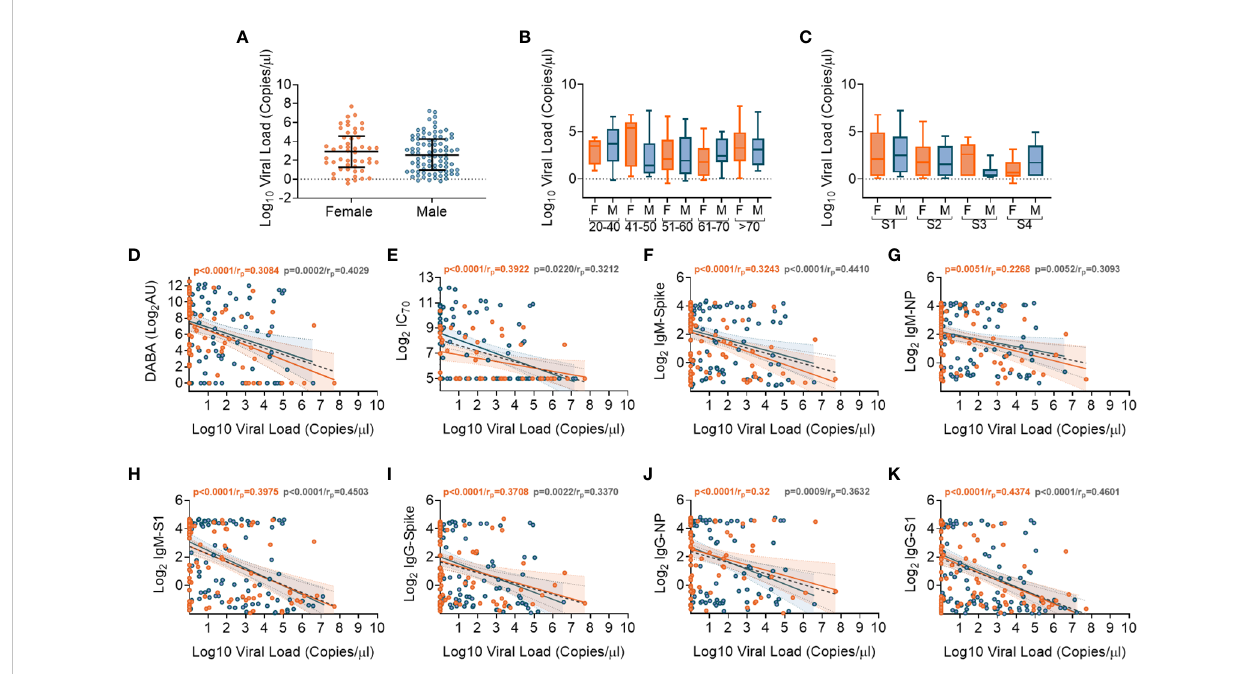
FIGURE 5 Association of SARS-CoV-2 upper respiratory tract viral loads in relation to sex, age and Ab responses at time of sampling. (A) Overall viral load measurements in relation to sex. (B) Viral loads according to age groupings and between females (orange) and males (blue). (C) Viral loads according to disease severity groupings (S1-S4) and between females (orange) and males (blue). (D) Associations between viral loads and overall DABA anti-RBD binding responses. (E) Associations between viral loads and neutralisation antibody (IC 70 ) responses. (F-H) Associations between viral loads and IgM antibody binding responses against spike (F) , NP (G) and S1 (H) antigens. (I-K) associations between viral loads and IgG antibody binding responses against spike (I) , NP (J) and S1 (K) antigens. (D-K) Inverse correlations shown (black dotted line) with males shown in blue and females in